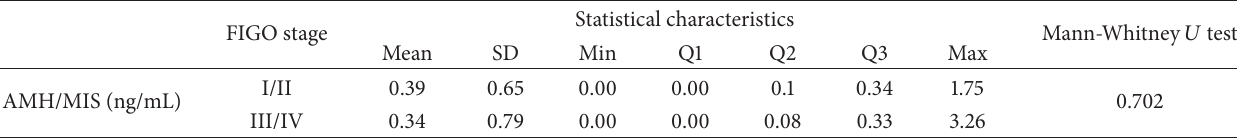
Table 2: AMH concentration in relation to FIGO stage.